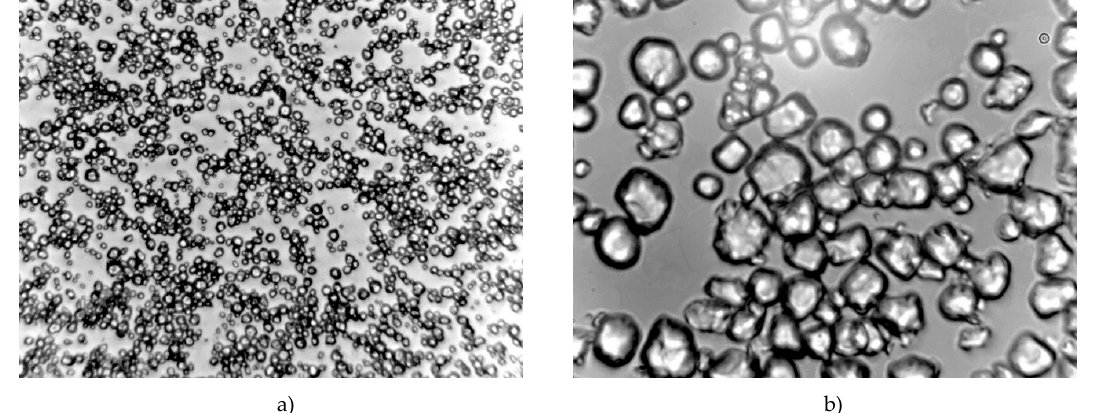
Figure 6. Microscopic appearance of the solution of HS-AA-10 copolymer; regime: 40 °C—10 min ( a ) magnification: 10×; ( b ) magnification 40×. Polymers 2019 , 11 , x FOR PEER REVIEW